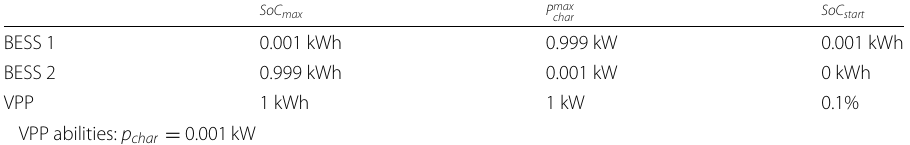
Table 1 Illustration of importance of heterogeneity: Consider a VPP consisted of two extreme BESSs, with one having the power capabilities of the VPP but with little energy storage and the other BESS having the energy storage of the VPP but with a very limited amount of charging power SoC max P max char SoC start BESS 1 0.001 kWh 0.999 kW 0.001 kWh BESS 2 0.999 kWh 0.001 kW 0 kWh VPP 1